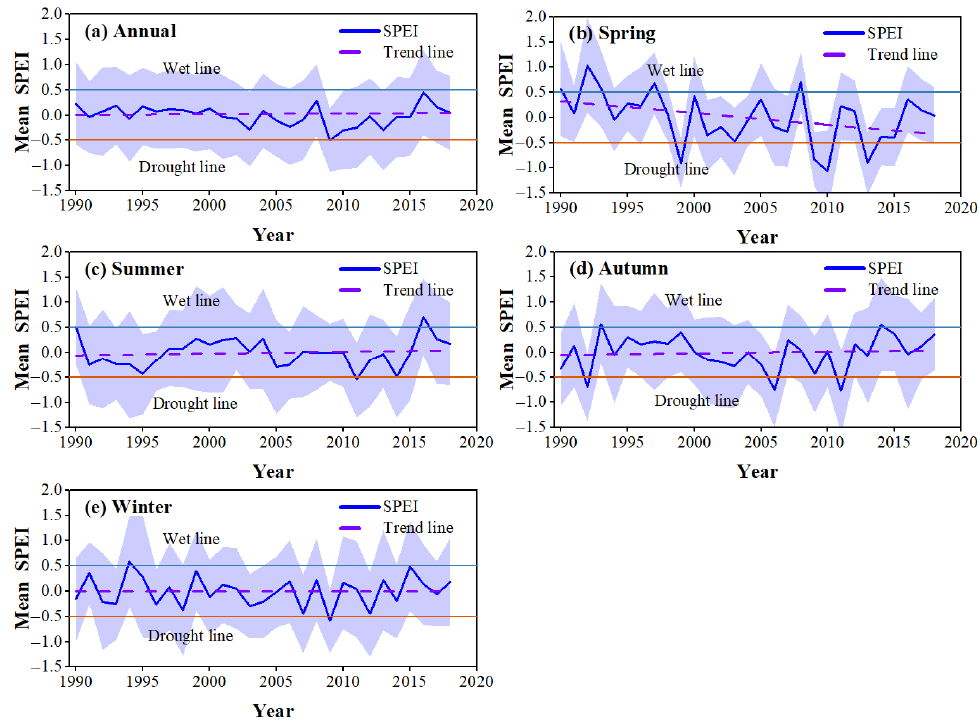
Figure 12. Temporal change trends in mean SPEI from 1990 to 2018. ( a ) Annual; ( b ) spring; ( c ) summer; ( d ) autumn; ( e ) winter. Figure 13a represents spatial pattern of trends in annual SPEI across southwest